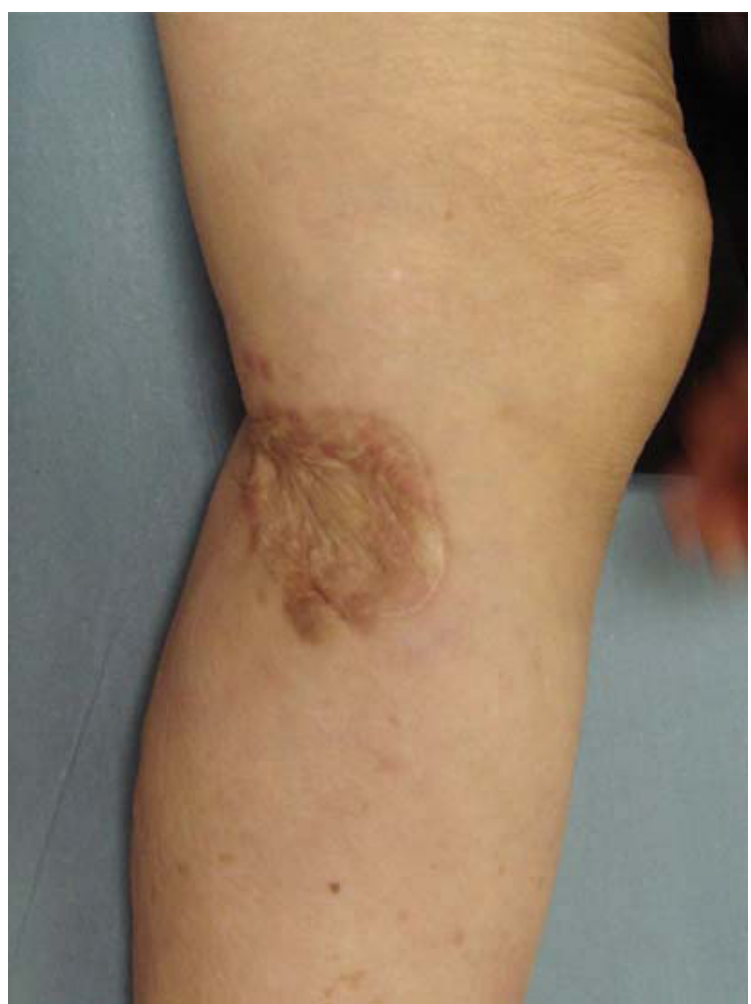
Figure 2. Six months after injury, the patient could return to